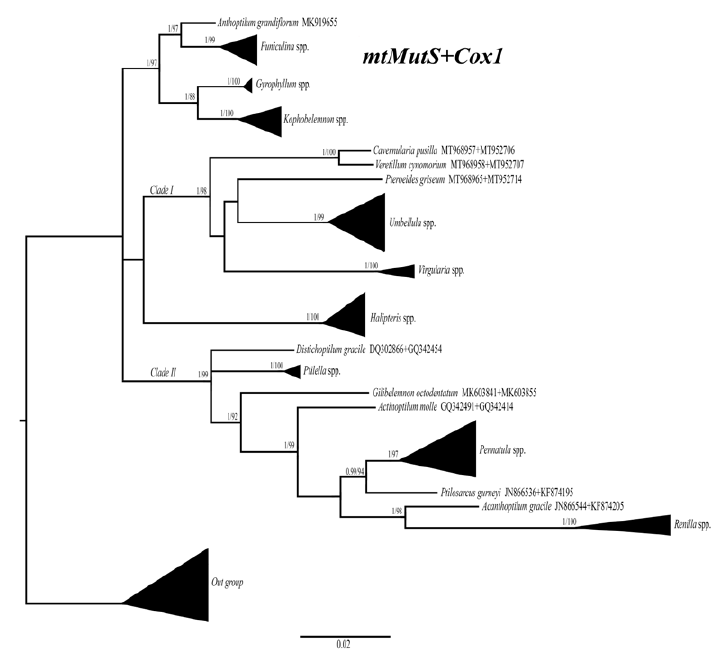
Fig. S4. – Phylogenetic relationships in the order Pennatulacea based on the maximum likelihood method for the concatenated mitochondrial markers mtMutS + Cox1. Posterior probability and bootstrap supporting values are indicated on the different nodes. See Table 1 for species and GenBank accession numbers used in this